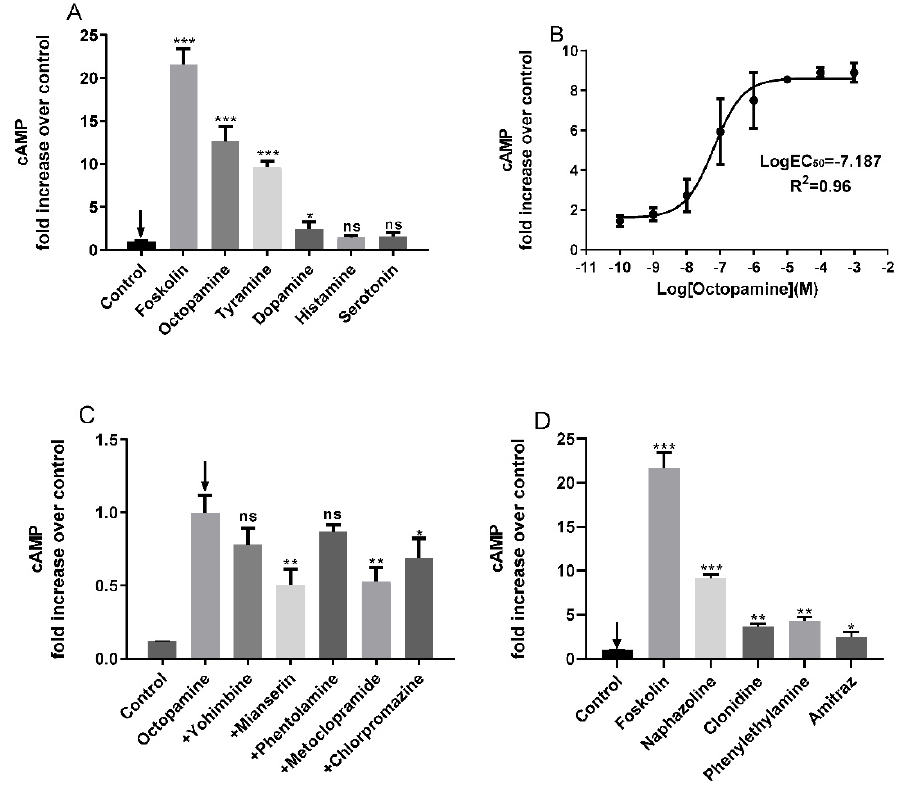
Figure 4. Effects of various biogenic amines, agonists, and antagonists on the concentration of cAMP in HEK-293 cells that overexpressed the PxOct β 3 gene. The pcDNA3.1-PxOct β 3 plasmid was stably expressed in HEK-293 cells, which were used to detect changes in the levels of intracellular cAMP after treatment with different biogenic amines, agonists, and antagonists. The relative concentration of intracellular cAMP was calculated by defining the concentration of cAMP in the control cells as 1 (4.08 ± 0.39 pmol/mg protein). ( A ) Effects of various biogenic amines on the levels of cAMP in HEK-293 cells that stably expressed the PxOct β 3 gene. HEK-293 cells that stably expressed PxOct β 3 were treated with forskolin as a positive control. The relative change in [cAMP] was provided as a multiple of the value obtained for the untreated control (=1). ( B ) Effects of different doses of octopamine on the levels of cAMP in HEK-293 cells that stably expressed PxOct β 3. ( C ) The effects of different antagonists (100 µ M) on the levels of cAMP in HEK-293 cells that stably expressed PxOct β 3. Data represent the mean of three experiments. ( D ) Effects of various agonists on the levels of cAMP in HEK-293 cells that stably expressed the PxOct β 3 gene. HEK-293 cells that stably expressed PxOct β 3 were treated with forskolin as a positive control. The statistical analysis was based on a one-way analysis of variance (ANOVA) followed by Tukey’s multiple comparison test. *** p ≤ 0.001, ** p ≤ 0.01, * p ≤ 0.05, ns means no